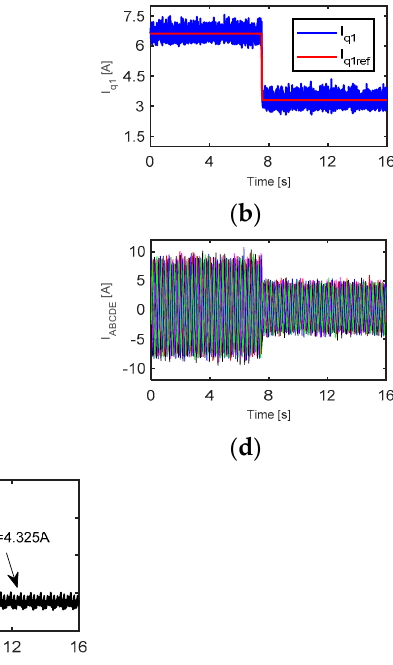
Figure 15. Measured and simulated average torque at ( a ) different current angles and 8.65 A and ( b ) different line currents and optimal current angles.